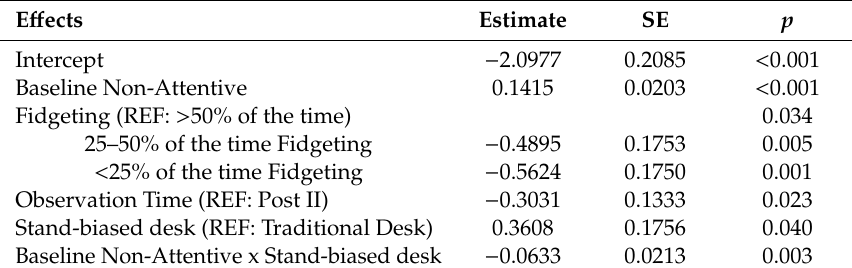
Figure 4. Illustration of the predicted number of non-attentive episodes at post intervention given the number of non-attentive episodes at baseline. Table 4. Results from negative binomial model.